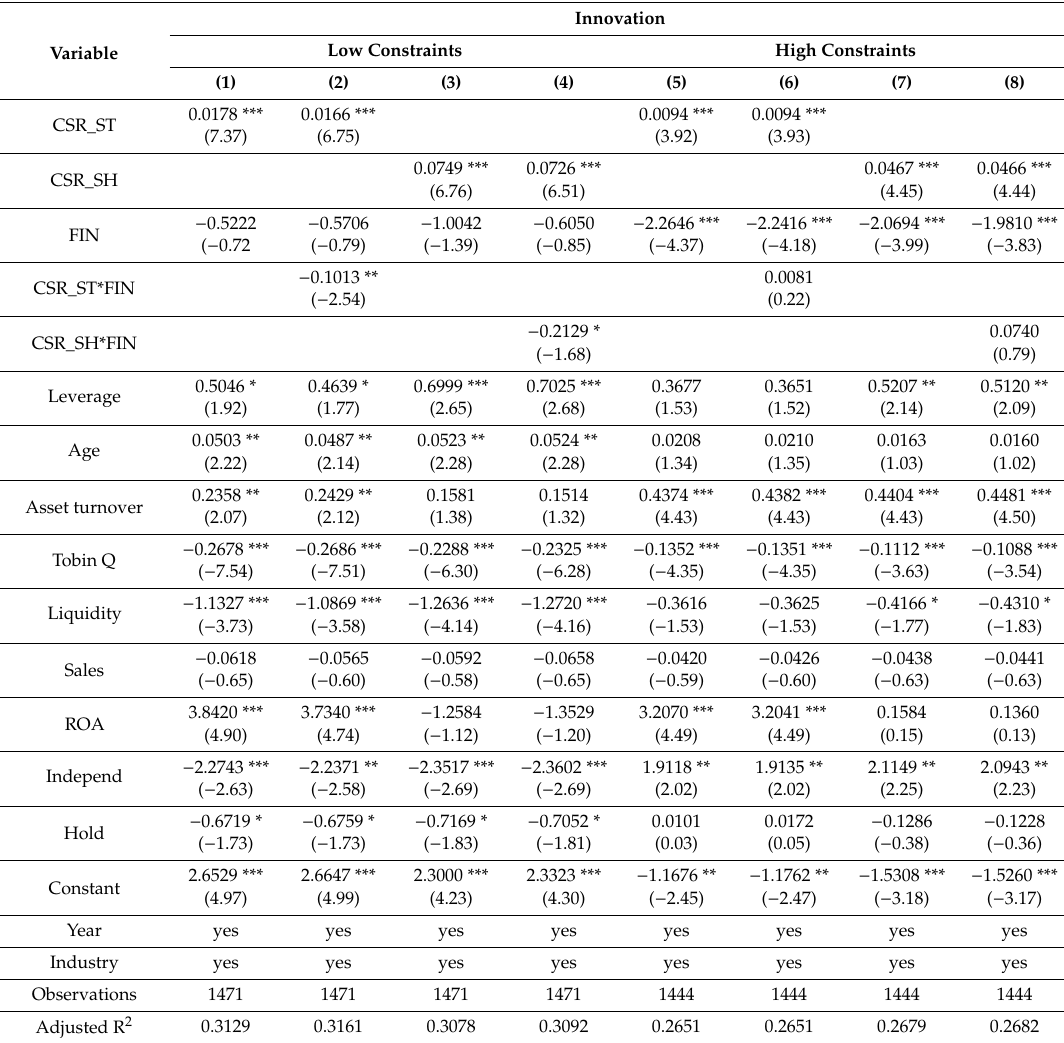
Table 10. Di ff erent CSR engagements with di ff erent